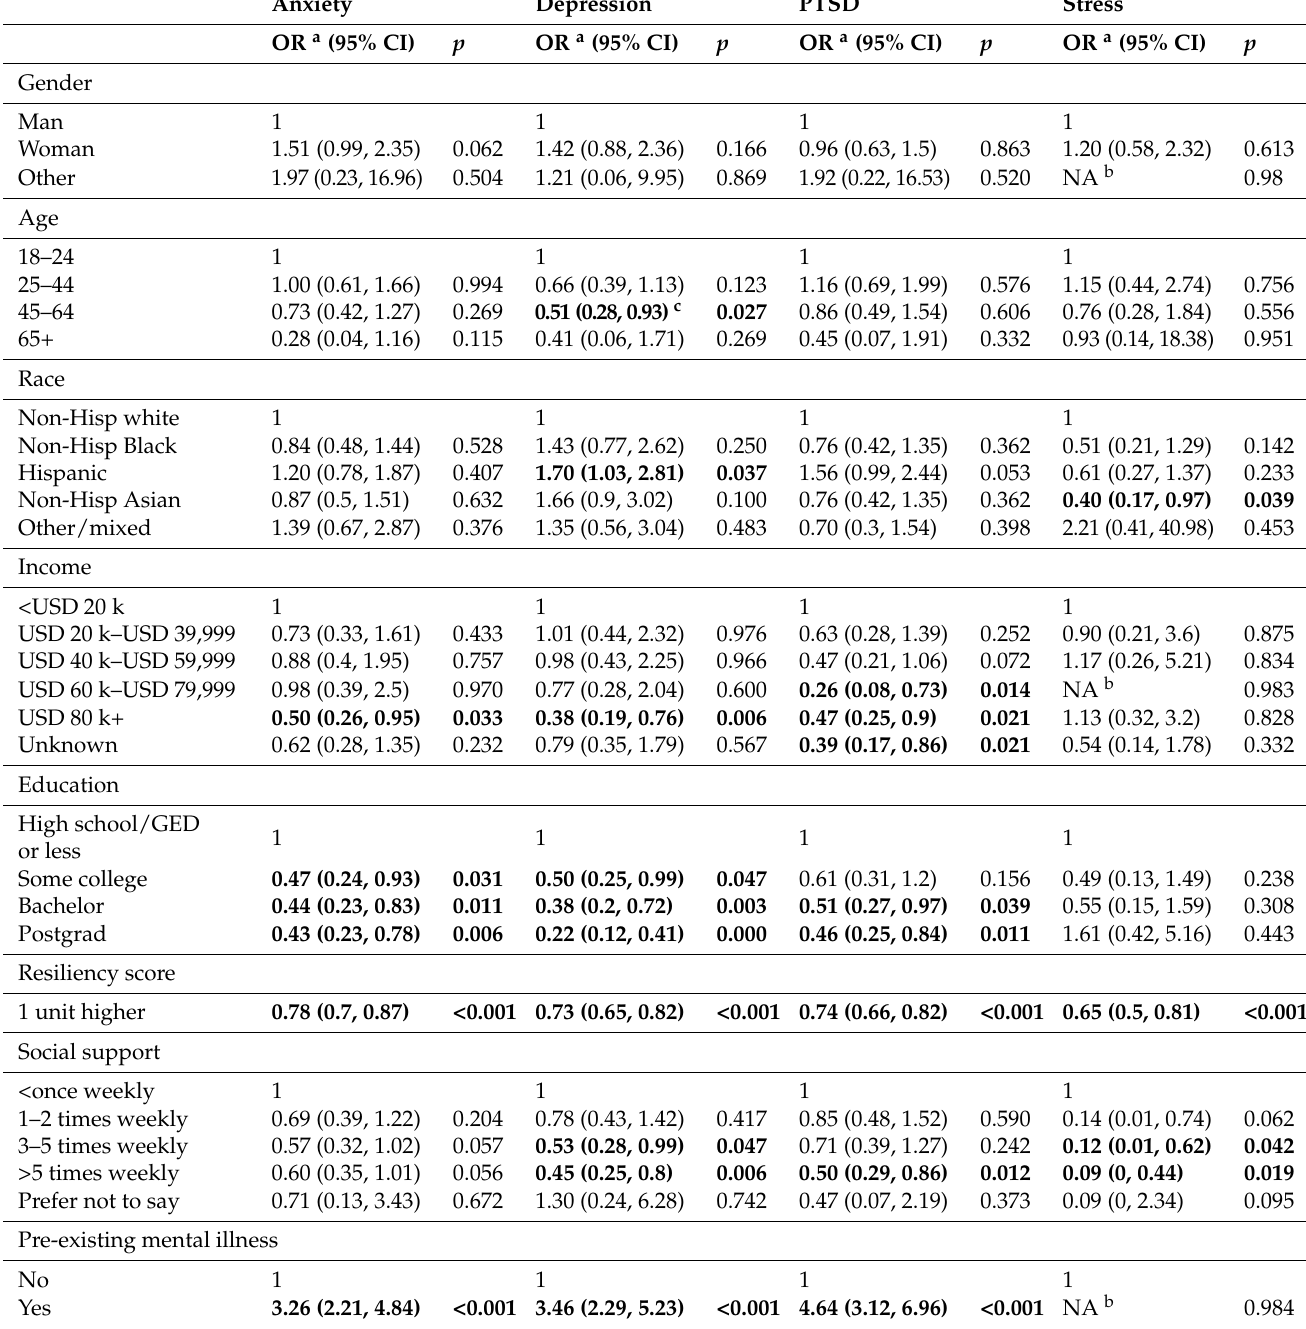
Table 3. Associations between individual factors and parent mental health symptoms, unadjusted